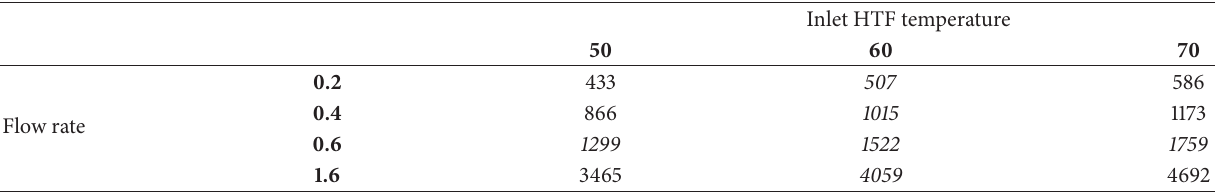
Table 2: Reynolds numbers for different flow rates and temperature